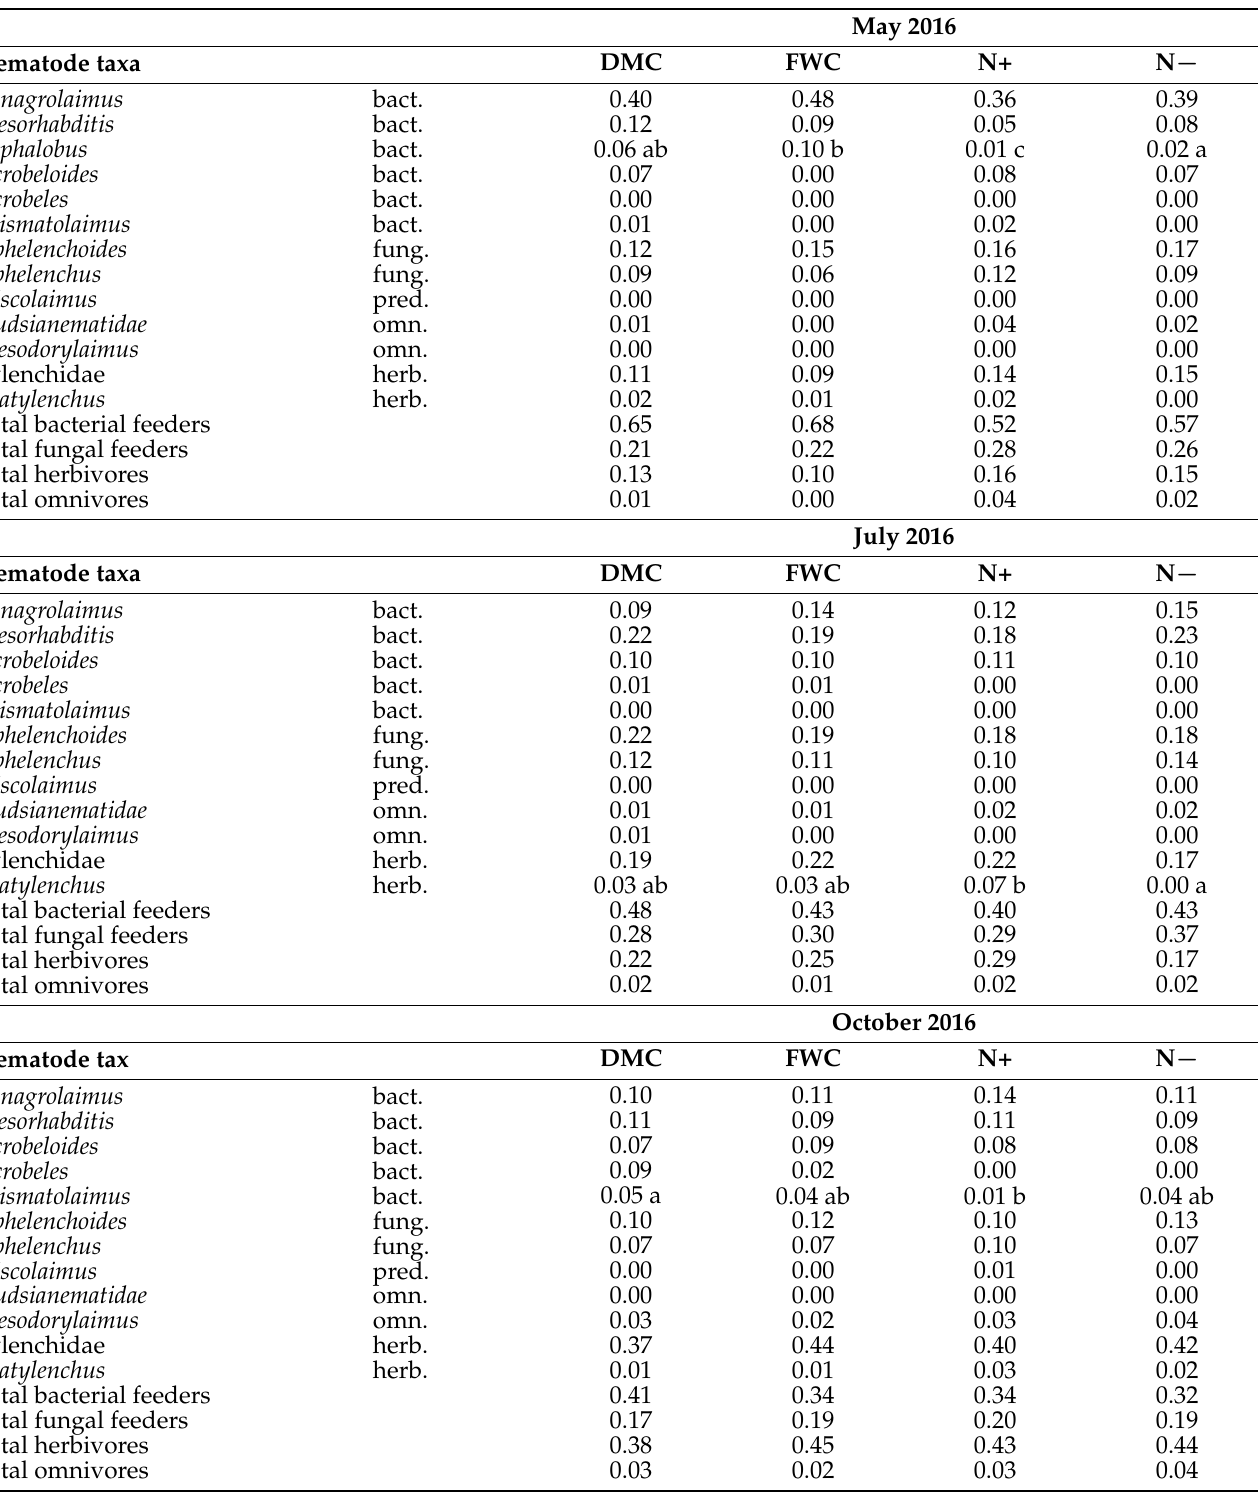
Table 3. The average relative abundance of individual nematode groups in year one from an almond orchard receiving different organic amendments. Letters denote statistical differences of p < 0.05 determined by Tukey’s honestly sig- nificant difference (HSD) test. DMC = Dairy manure compost, FWC = Food waste compost, N+ = nitrogen fertilizer, and N − = unamended control. For trophic groupings of nematodes bact. = bacterial feeders, fung. = fungal feeders, omn. = omnivores, pred. = predators, and herb. = root herbivores. Categories with 0 values indicate relative abundances under 0.01